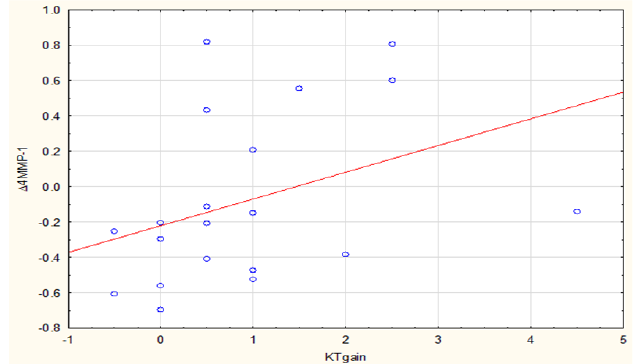
Figure 3. Correlation between ∆ 4MMP-1 (3M-0) and KTgain after SCTG.